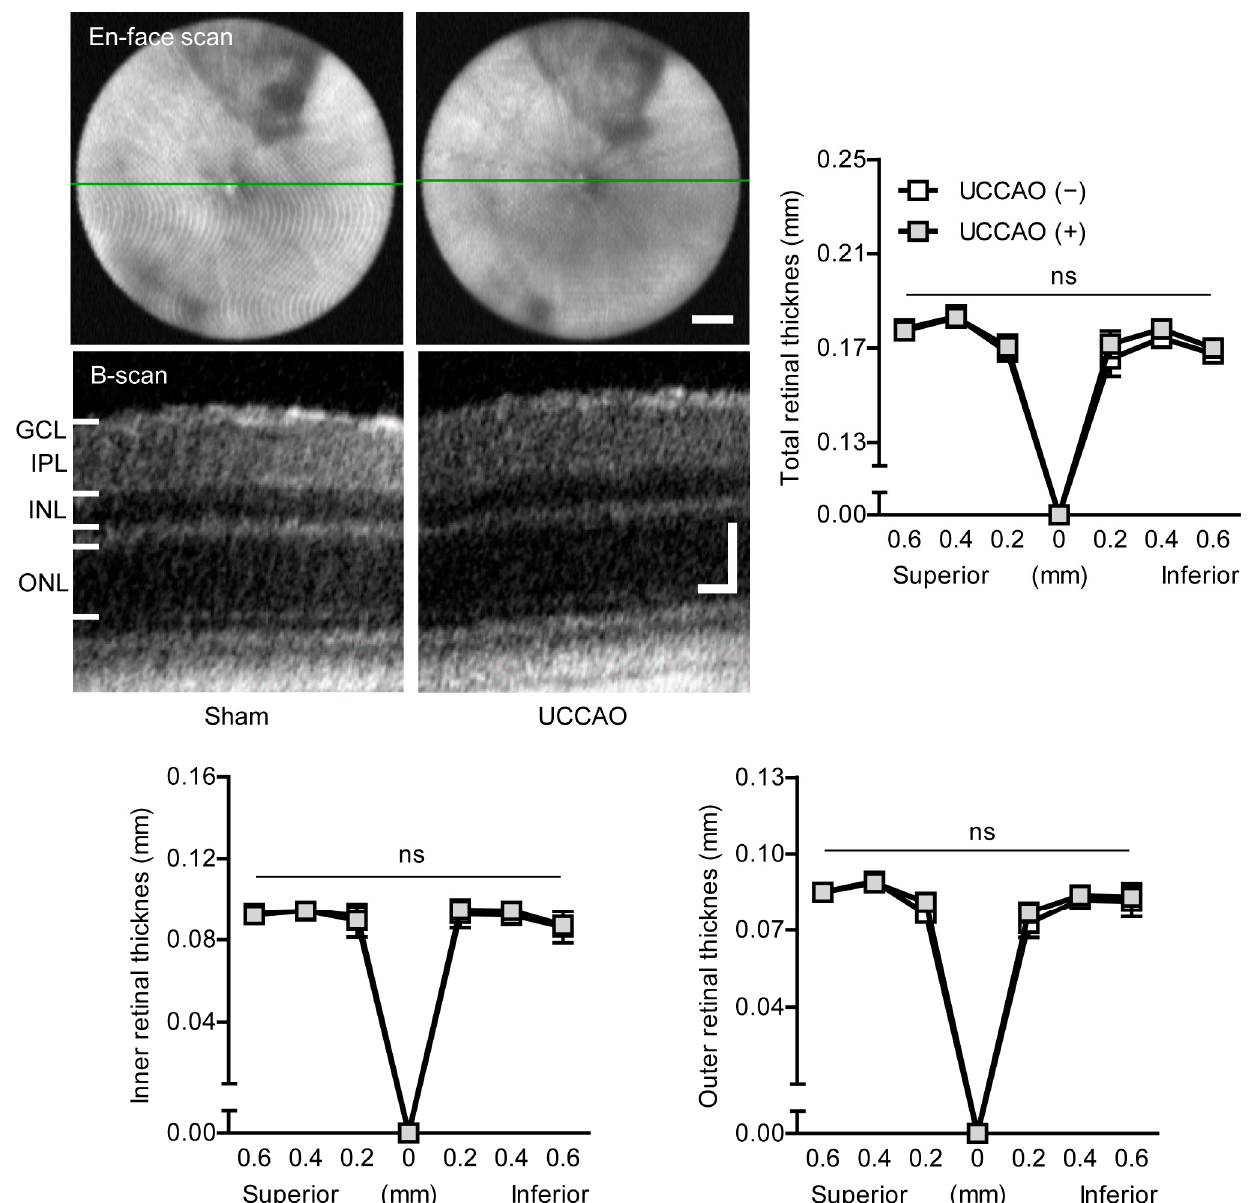
Figure A3. No change in retinal thickness after UCCAO. Representative optical coherence tomography (OCT) images (b-scan) in the sham- and UCCAO-operated retinas and quantitative analyses ( n = 4–5 per group) show that there was no change in retinal thickness 7 weeks after UCCAO. The values in the horizontal axis of the graph represent 0.2, 0.4 and 0.6 mm distance from the optic nerve head (0) which was detected by the green line (en-face scan). Representative OCT images were taken at 0.4 mm from the optic nerve head. The data were analyzed using two-way ANOVA followed by a Bonferroni post hoc test and presented as a spider diagram (mean ± standard deviation). p > 0.05. GCL, IPL, INL, and ONL represent the ganglion cell layer, inner plexiform layer, inner nuclear layer, and outer nuclear layer, respectively. Scale bars are 200 (upper) and 50 (lower; vertical and horizontal bars) μ m, respectively. UCCAO; unilateral common carotid artery occlusion.